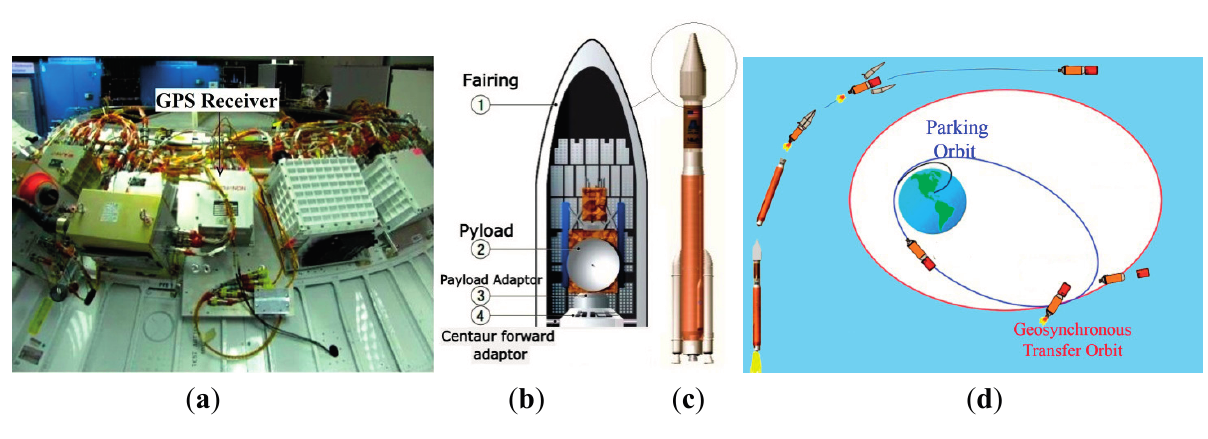
Figure 2. Launch vehicle Atlas V. ( a ) Installation position of GPS receiver on the centaur forward adaptor; adapted from [4]; ( b ) position of the centaur forward adaptor inside the fairing; adapted from [5]; ( c ) position of the fairing in the launch vehicle; adapted from [5]; ( d ) trajectory; adapted from